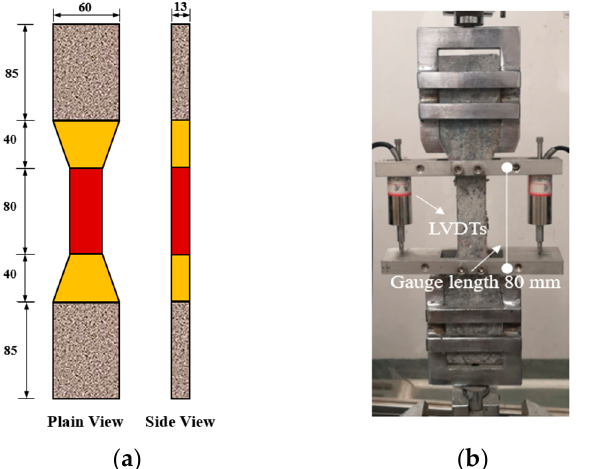
Figure 2. Dog-bone shaped specimen for tensile test: ( a ) geometric size; ( b ) test instrument. (unit: mm).